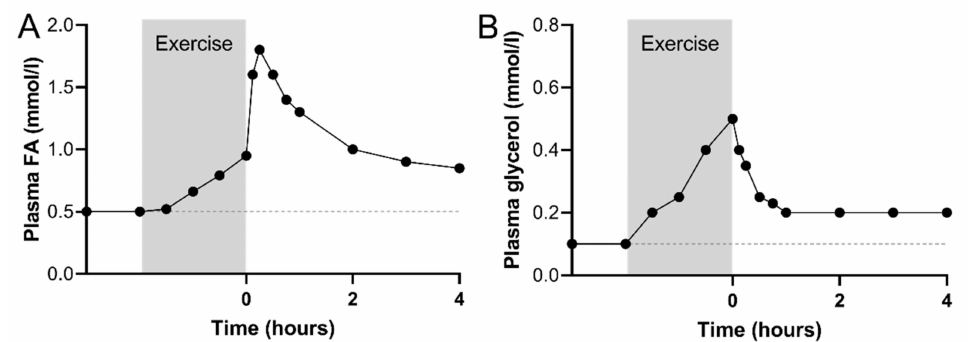
Figure 1. Representative illustration of plasma fatty acid (FA) ( A ) and glycerol ( B ) concentrations during moderate-intensity exercise (80 min to 4 h at 40%–70% of maximal oxygen consumption rate (VO 2 peak)) and in early recovery in endurance-trained subjects. Subjects remained fasted in recovery. The scatter plots are based on data in references